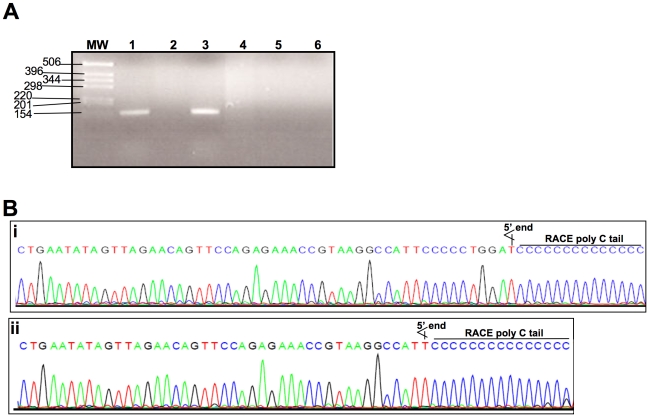
RT-PCR detection of sodC mRNA in B. neotomae and B. abortus RB51 (A) and identification of their 5′ ends by RACE analysis (B).A) Total RNA extracted from the bacterial cultures at late log phase was used as template in RT-PCR or direct PCR for amplification of a 5′ portion of sodC mRNA using a pair of specific primers. Post-amplification reaction mixtures of tubes containing RNA extracted from B. neotomae (lanes 1 and 2) or B. abortus RB51 (lanes 3 and 4) were separated on a 2% agarose gel by electrophoresis and stained with ethidium bromide to visualize the DNA fragments. Lanes 1 and 3, RT-PCR reaction mixtures. Lanes 2 and 4, PCR reaction mixtures. Lanes 5 and 6, reaction mixtures from no-template-controls of RT-PCR and PCR reactions, respectively. Lane marked MW contains DNA molecular size marker, and the numbers at the left indicate molecular size in base-pairs. B) Representative nucleotide sequencing chromatograms showing the location of 5′ ends of the cloned sodC cDNAs from B. abortus RB51 (i & ii) and B. neotomae (ii).